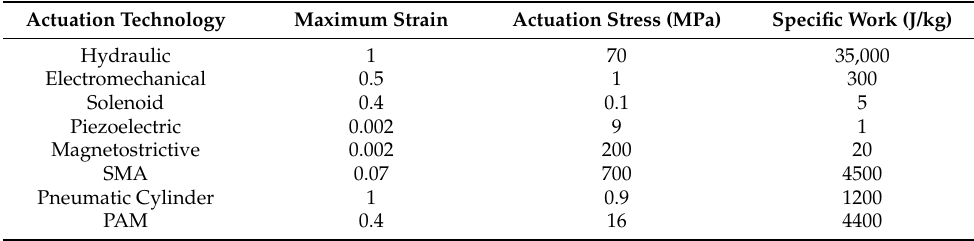
Table 1. Comparison of actuator technologies